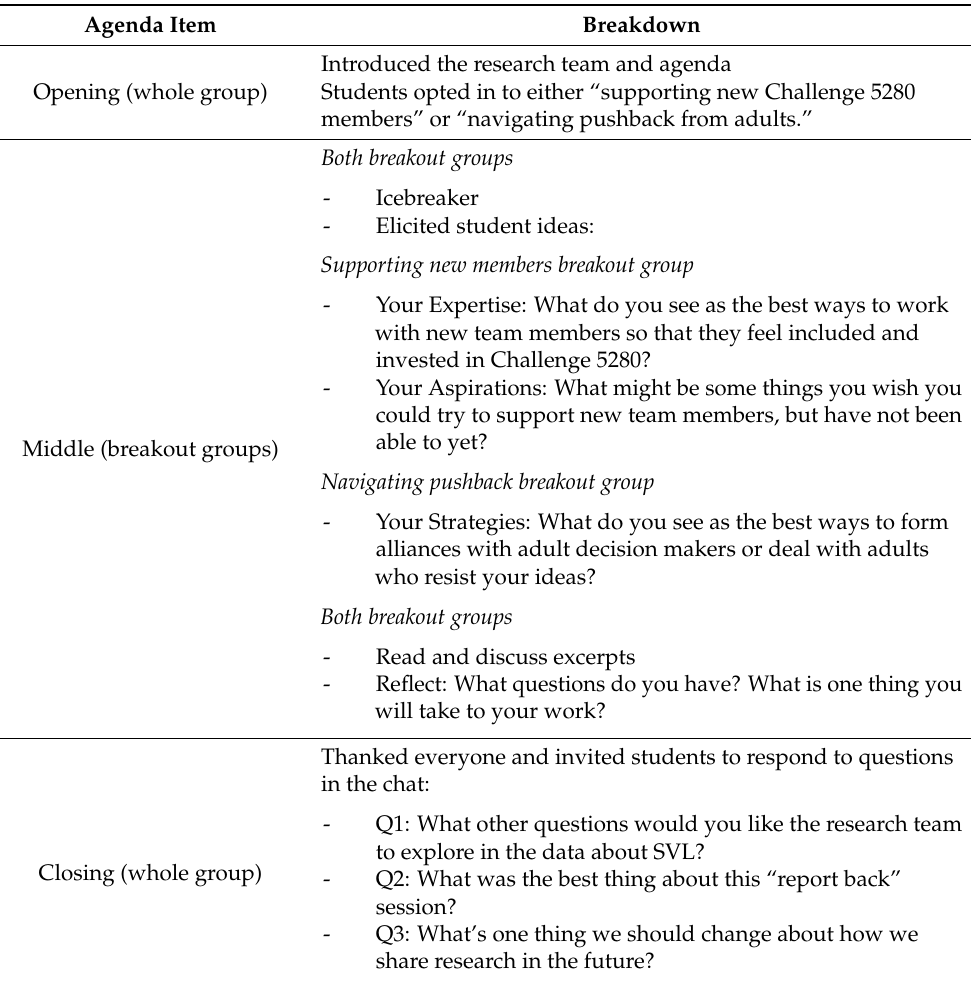
Table 2. Student Session